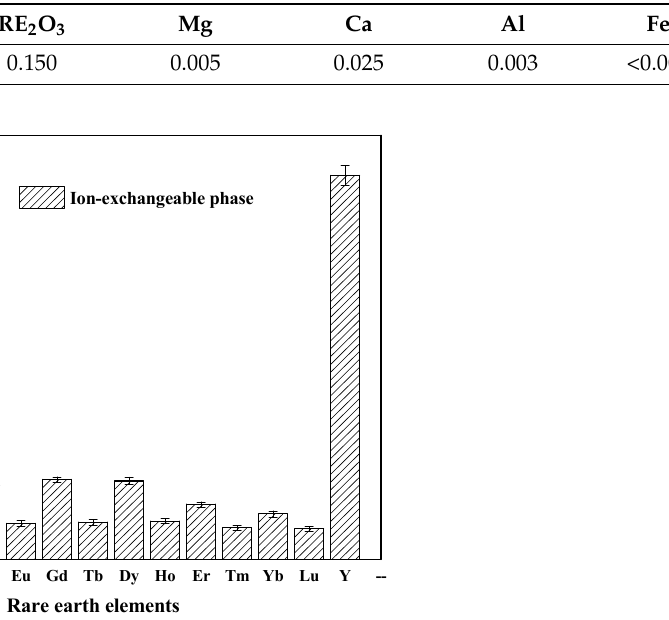
Figure 1. Rare earth distribution patterns of the ion-exchangeable phase (mass fraction %).